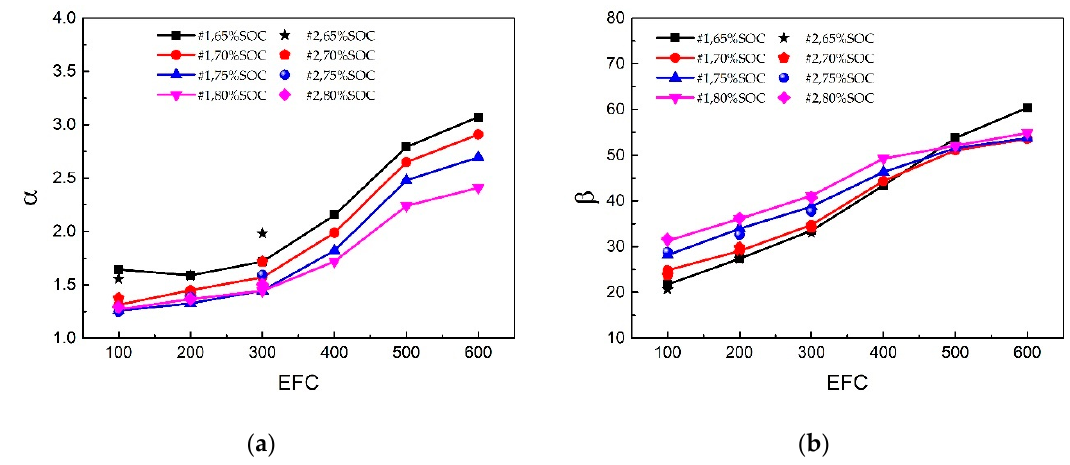
Figure 9. Relationship between relaxation voltage model parameters and aging cycles at 65%, 70%, 75%, and 80% SOC under charging condition of cell #1. ( a ) results of α ; ( b ) results of β .